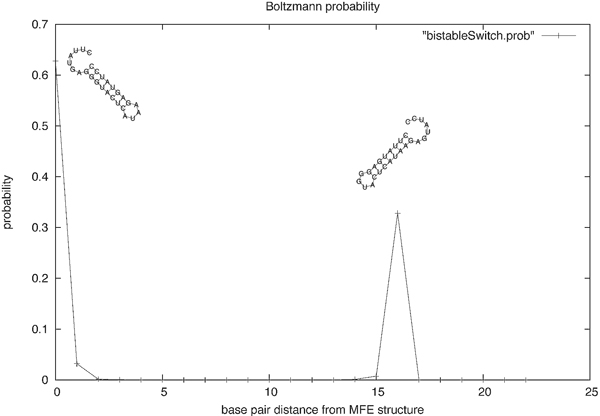
Output of RNAboron the 27 nt bistable switch with nucleotide sequence CUUAUGAGGG UACUCAUAAG AGUAUCC and initial structure S0, the minimum free energy (MFE) structure....... ((((((((....)))))))) with free energy -10.3 kcal/mol. The 16-neighbor of S0 is the metastable structure ((((((((....))))))))....... with free energy -9.9 kcal/mol. The MFE structure appears above the leftmost peak, while the MFE(16) structure appears above the rightmost peak. The output of RNAbor includes a graph of the Boltzmann probabilities pk=ZkZ, and MFE(k) structures, for all 0 ≤ k ≤ 2n. The existence of distinct 'peaks' suggests the presence of a conformational switch.